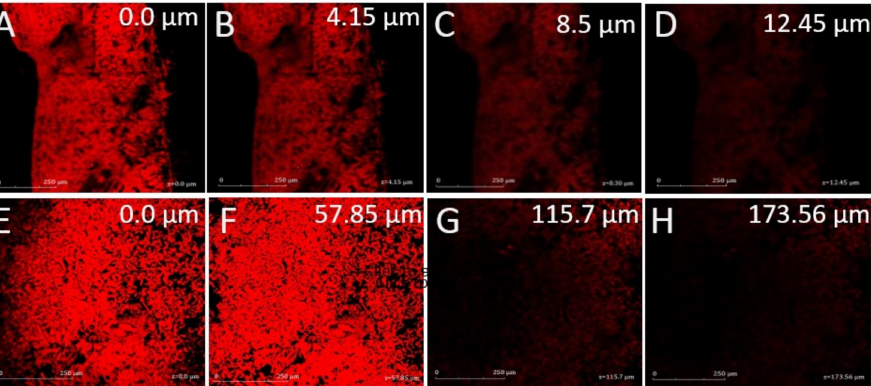
Figure 6. Confocal laser microscopy of ( A – D ) Rhodamine B solution and ( E – H ) Rhodamine B-loaded glycerosome, scale bar = 250 µ